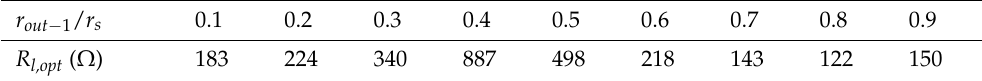
Table 4. The optimal load resistances corresponding to different radius of output electrodes.